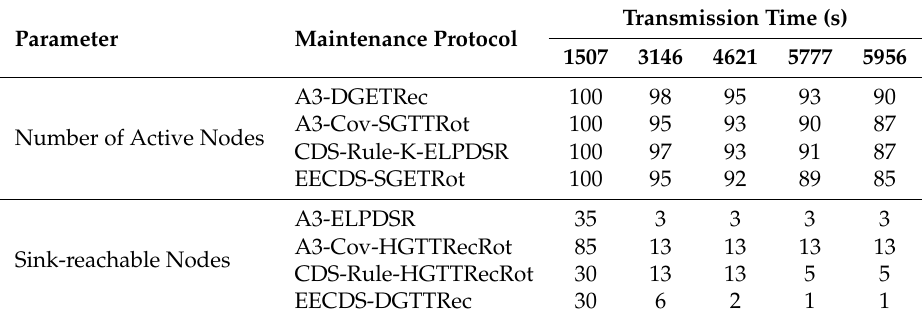
Table 5. Comparison of performances in terms of numbers of active and sink-reachable nodes. Parameter